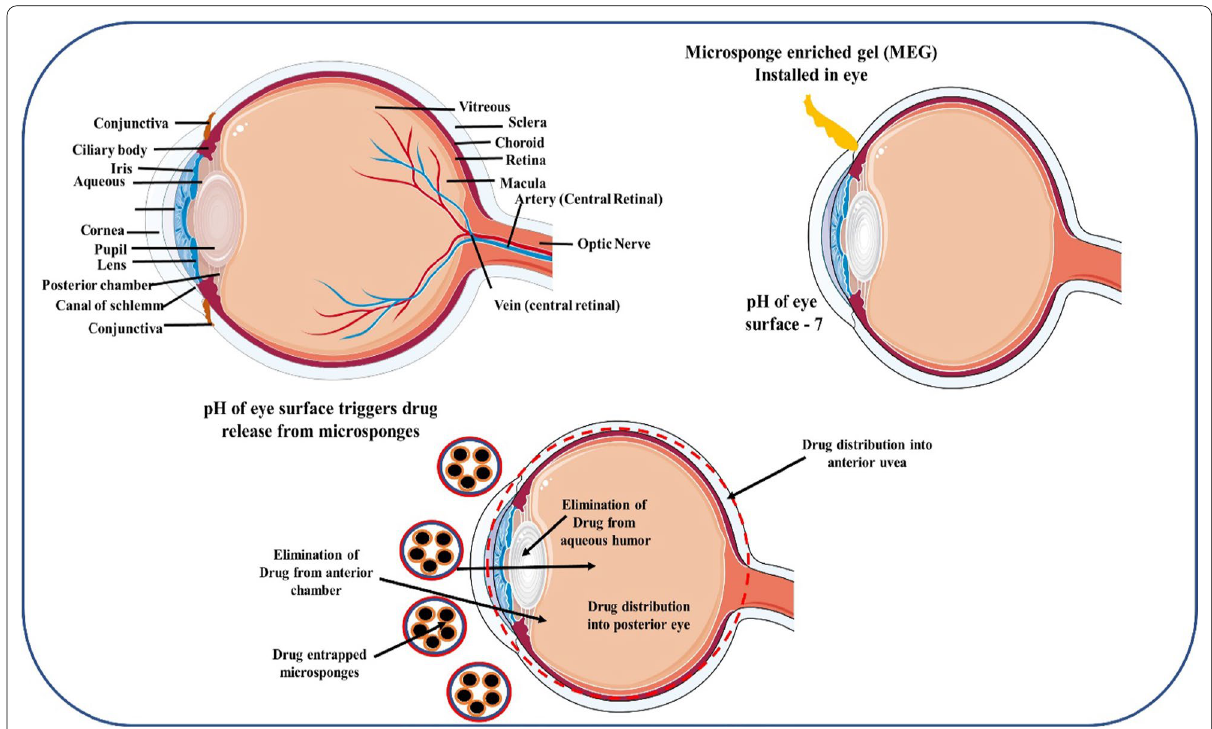
Fig. 10 Drug release mechanisms from microsponges for ocular drug